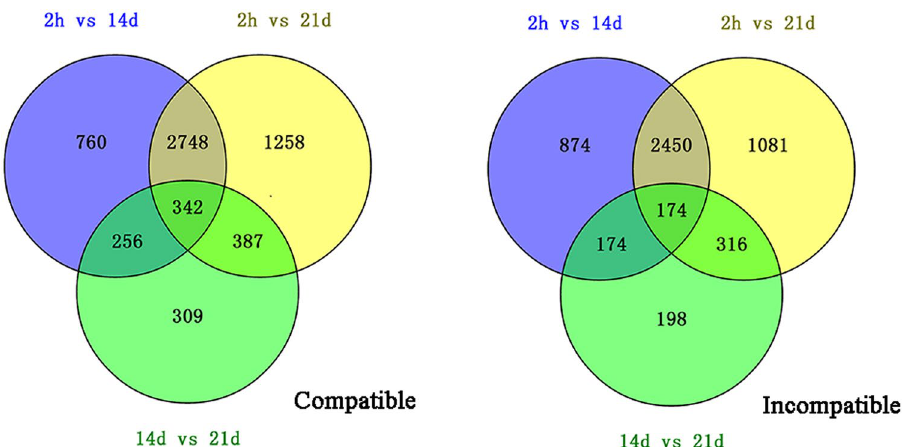
Figure 3. Venn diagram showing total number of the differentially expressed genes between the compatible combination and incompatible